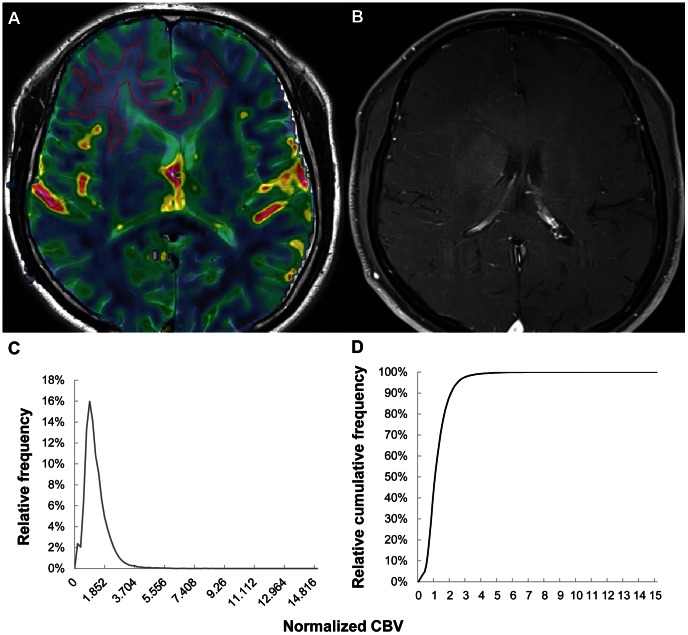
Images of a 55-year-old male with a grade II astrocytoma.(A) ROI-drawn rCBV map overlaid on a T2-weighted image, (B) contrast-enhanced T1-weighted image, (C) histogram of nCBV and (D) cumulative nCBV histogram. The 99th percentile value of the cumulative nCBV histogram was 3.703. ROI = region of interest; rCBV = relative CBV; nCBV = normalized CBV.